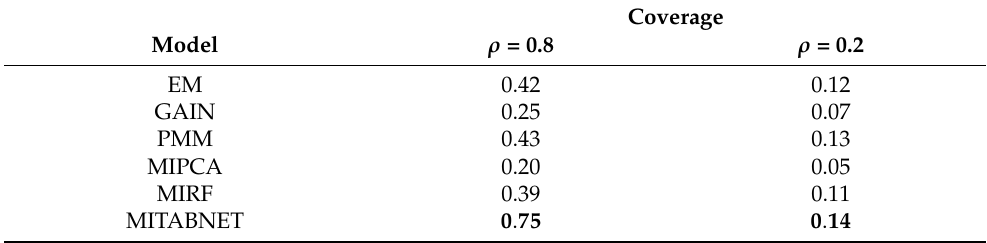
Table 4. Coverage in synthetic data: high and low correlation scenario for a sample size of 10,000.